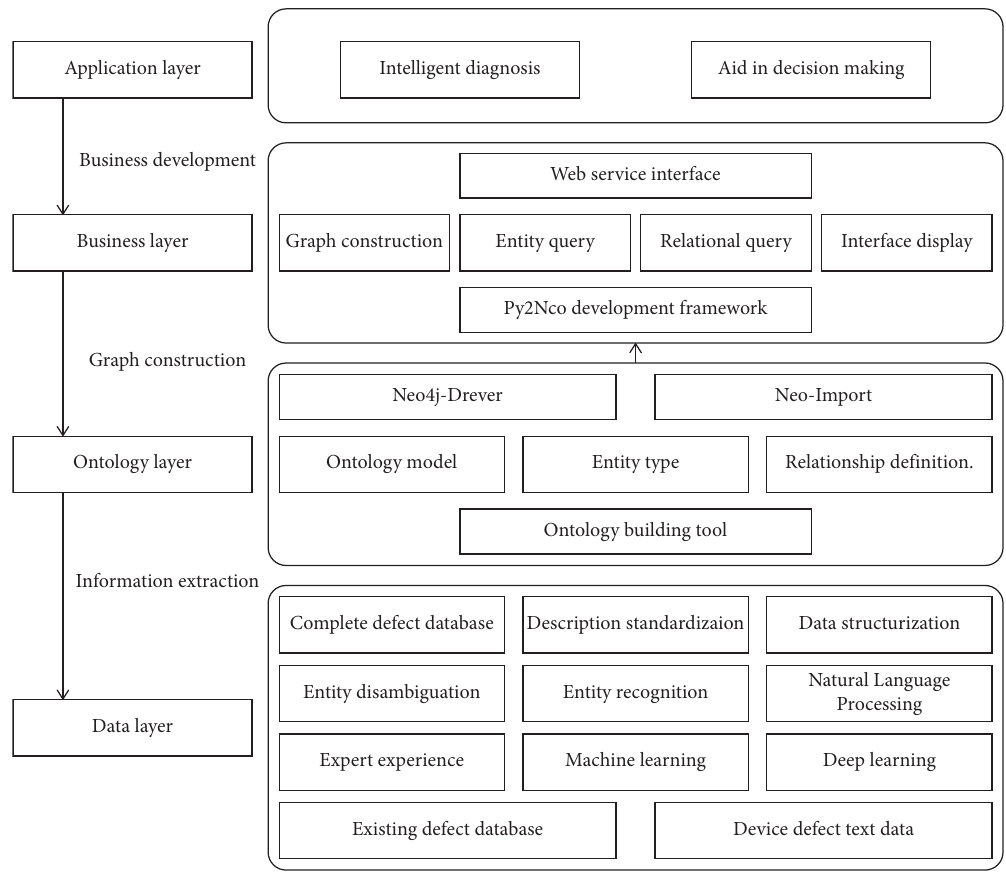
Figure 2: CAD-aided intelligent operation and maintenance platform for equipment functional